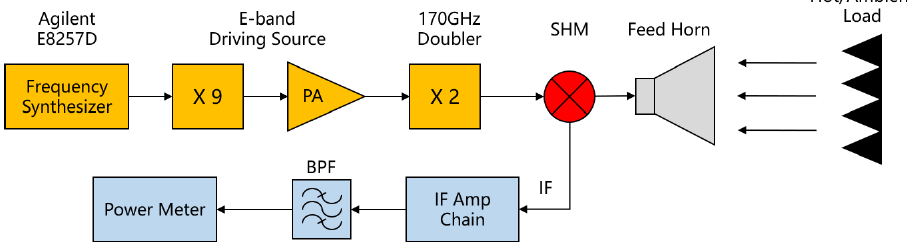
Figure 14. Schematic diagram of 0.34 THz SHM’s noise temperature test setup.